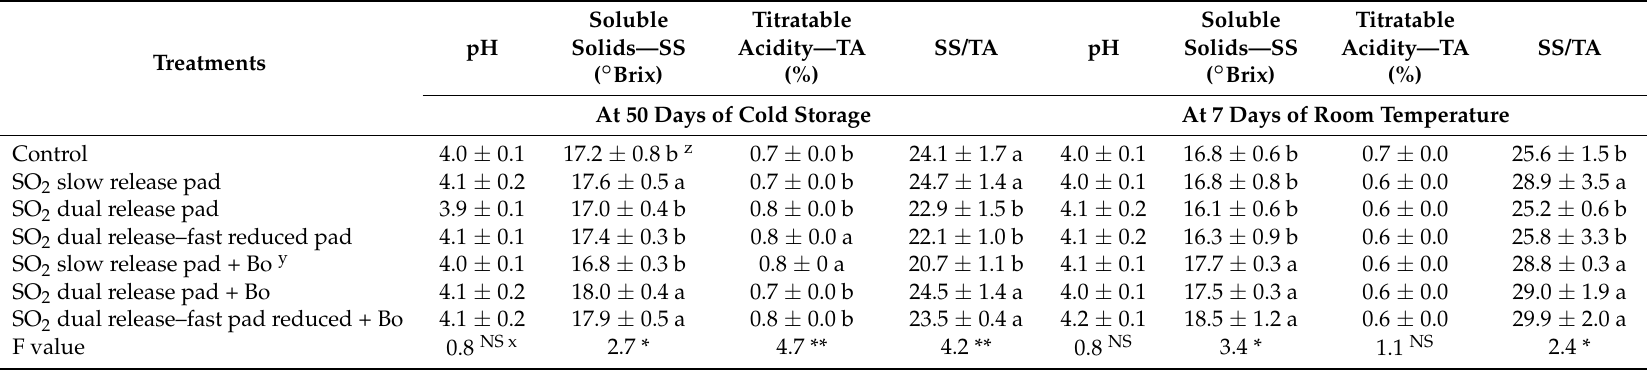
Table 5. pH, soluble solids (SS), titratable acidity (TA), SS/AT of ‘BRS Vitoria’ seedless table grape at 50 days of cold storage, and 7 days of room temperature under different SO 2 pad